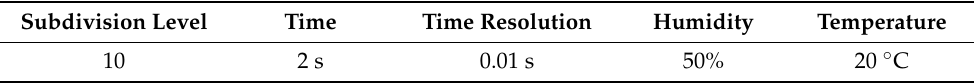
Table 3. Parameters set in Ramsete.